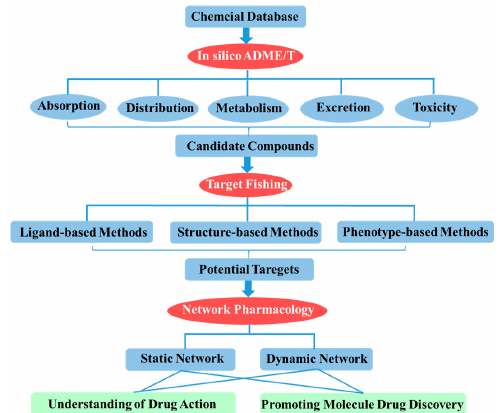
Figure 1. Flowchart for systems pharmacology-based drug discovery.